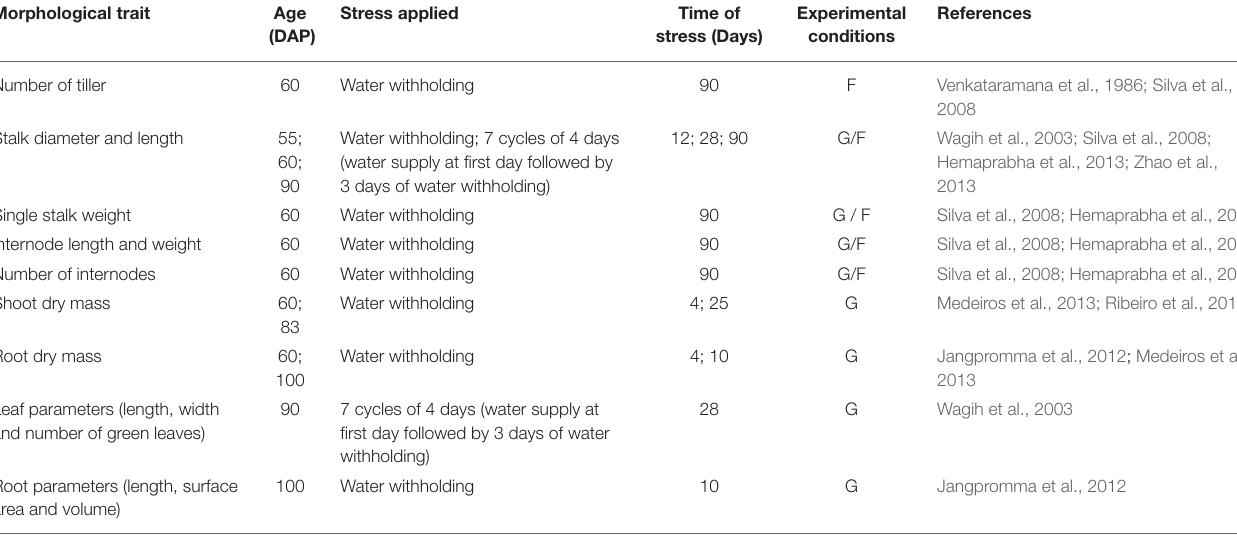
TABLE 1 | Morphological traits used to differentiate the degrees of drought resistance in sugarcane genotypes. Morphological trait